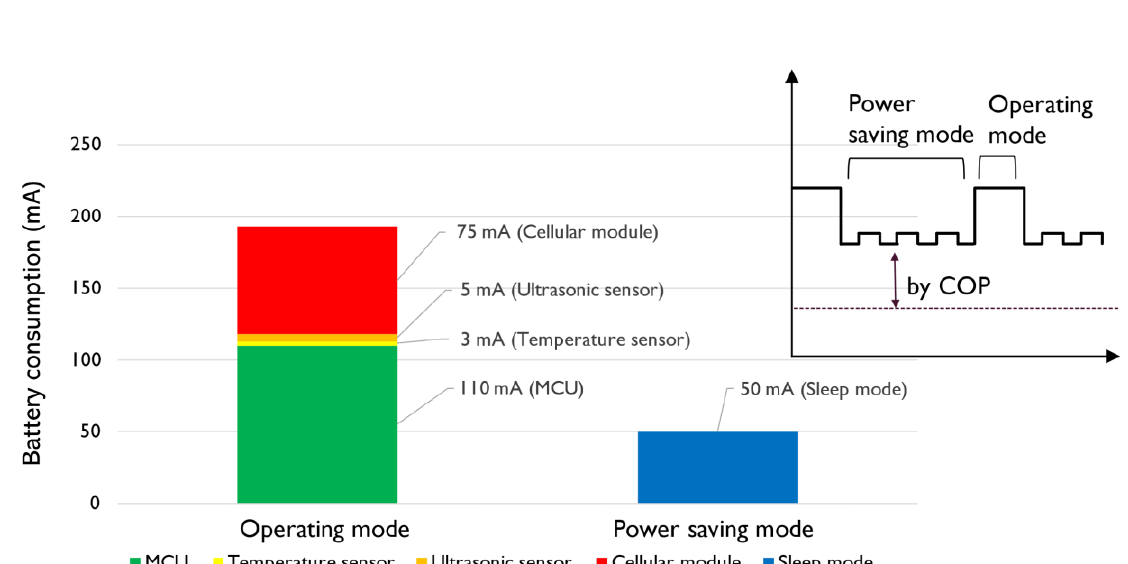
Figure 12. Battery consumption by components under the operating and power-saving mode in the single MCU system (UWLD-1). The results imply most of the battery power is consumed by MCU operation in both operating mode and power-saving mode.